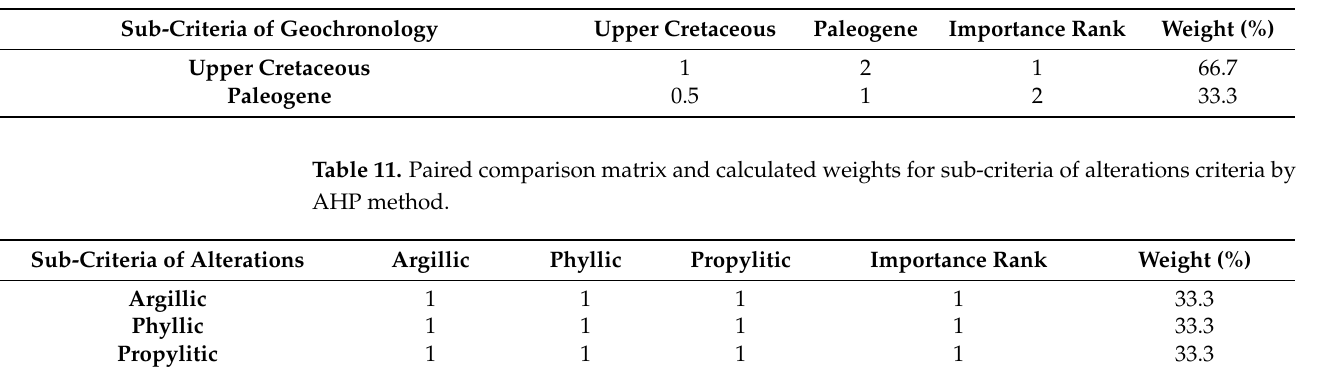
Table 10. Paired comparison matrix and calculated weights for sub-criteria of geochronology criteria by AHP method.